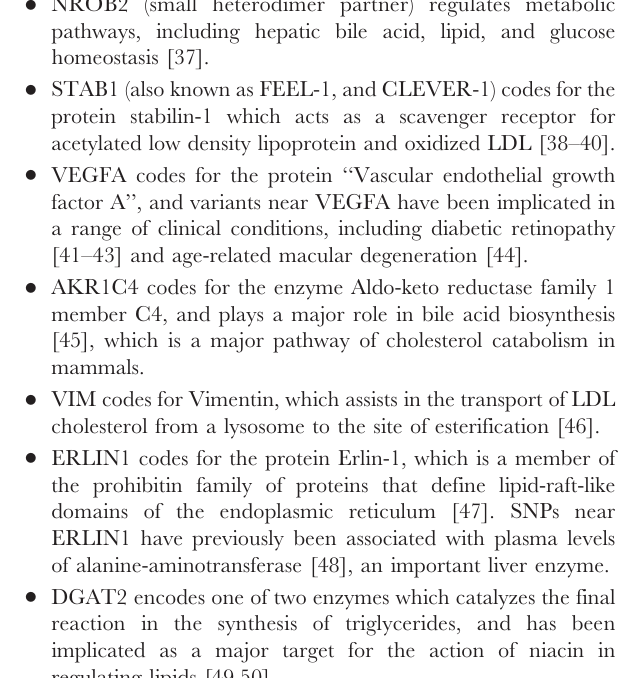
Table 1. Table of genes from Global Lipids study [34], that, in our analysis, are best classified as being unassociated with one of the four lipid traits. (All other genes were best classified as being associated with all four lipid traits).